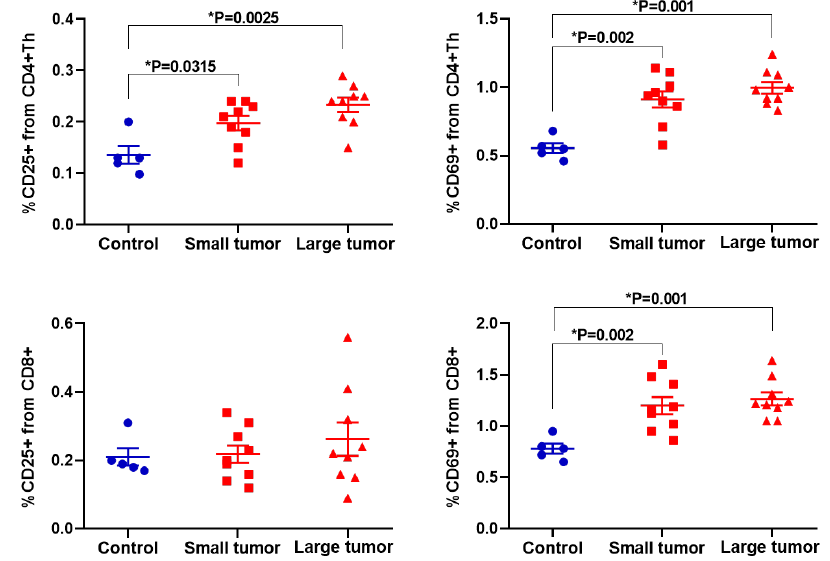
Figure 4. Expression of CD69 and CD25 in live CD4+ Th and CD8+ T-cells. Scatter dot plots display the measurements for individual animals (dots) and the mean and SEM (horizontal lines).